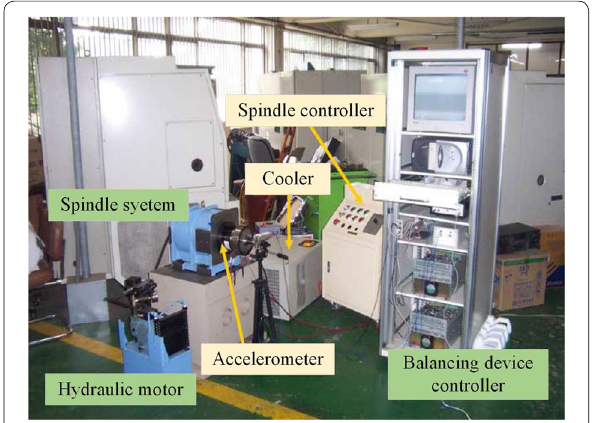
Figure 18 Balance experimental device of Moon et al.